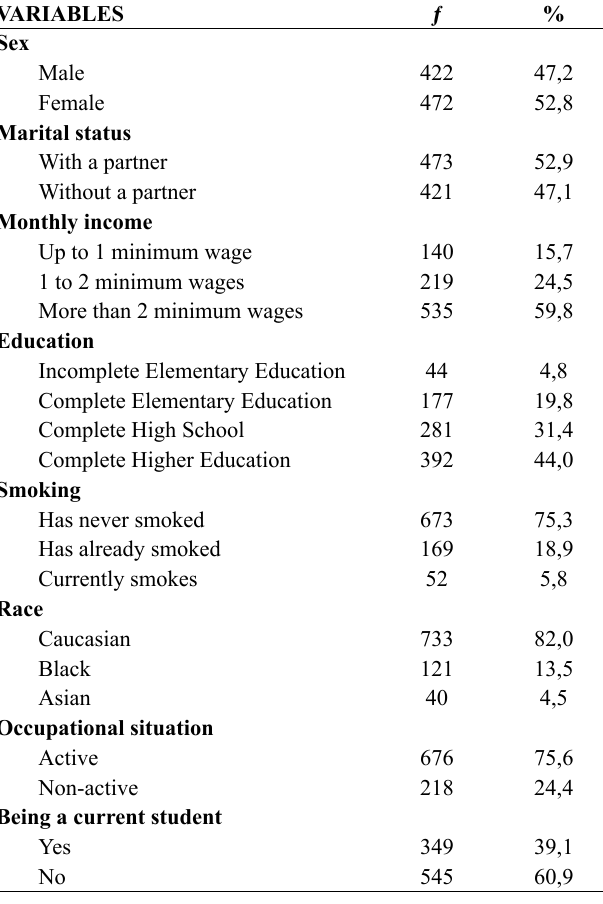
Table 1. Socio-demographic profile of the weight training practi - tioners in Maringá, Paraná, Brasil.